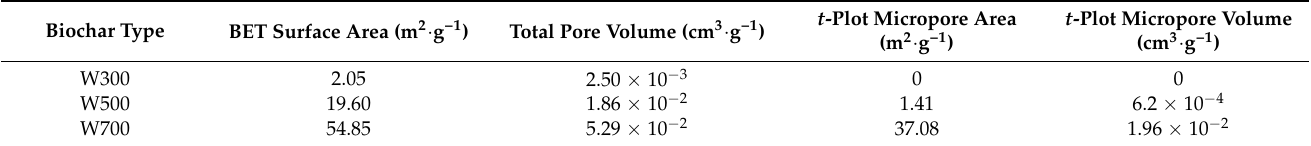
Table 1. Basic physical properties of wheel wingnut-based biochar pyrolyzed at different temperatures. Biochar Type